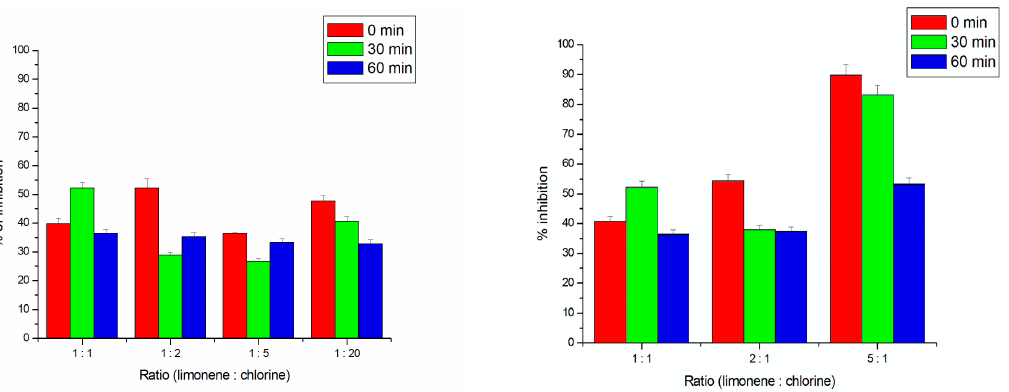
Figure 10. Bioluminescence inhibition of V. fischeri for selected chlorination mixtures of limonene/ac- tive chlorine ratio 1:1, 1:2, 1:5, 1:20 ( left ) and 1:1, 2:1, 5:1 ( right ) in buffer solution at 0, 30, and 60